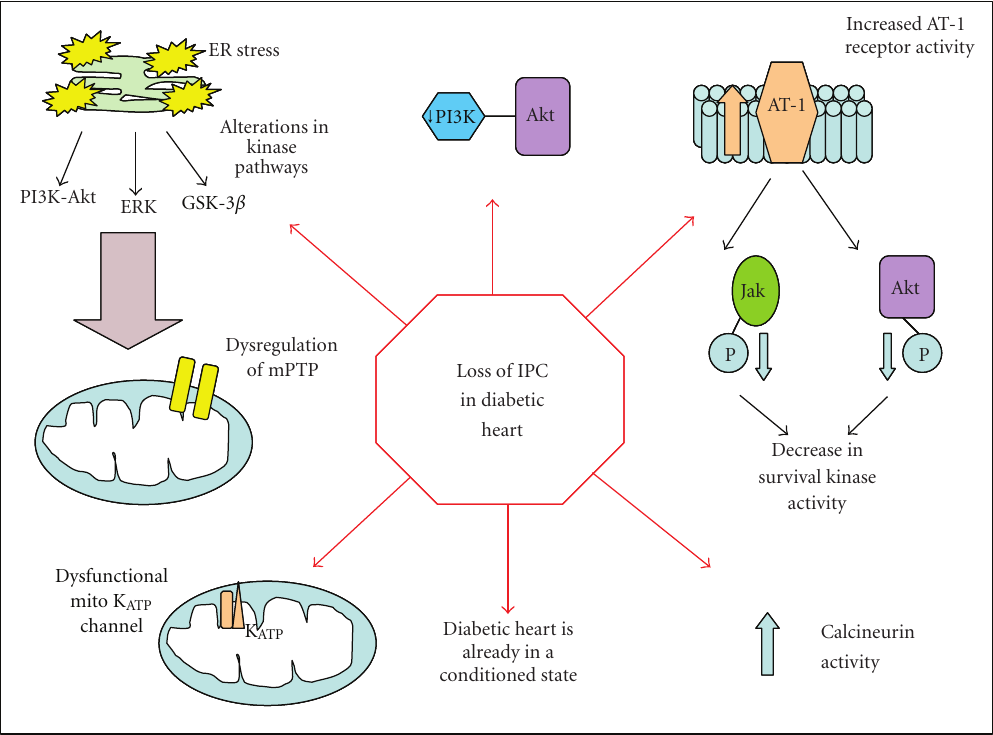
Figure 4: Why is the diabetic heart harder to protect with conditioning strategies? The diabetic heart has been suggested to have a raised threshold for cardioprotection [55], this is caused by the downregulation of prosurvival kinase pathways [55, 88], resulting in dysregulation of mitochondrial permeability transition pore (mPTP), increased receptor activities for pharmacological agents [78], increased calcineurin activity [81] and evidence suggests a dysfunctional K ATP channel in the mitochondria [76]. In diabetes, endoplasmic reticulum (ER) stress also causes alterations in kinase pathways leading to dysregulation of the mPTP [85]. Interestingly, some evidence suggests that the diabetic heart is in a paradoxical protective state therefore conditioning potential is lower